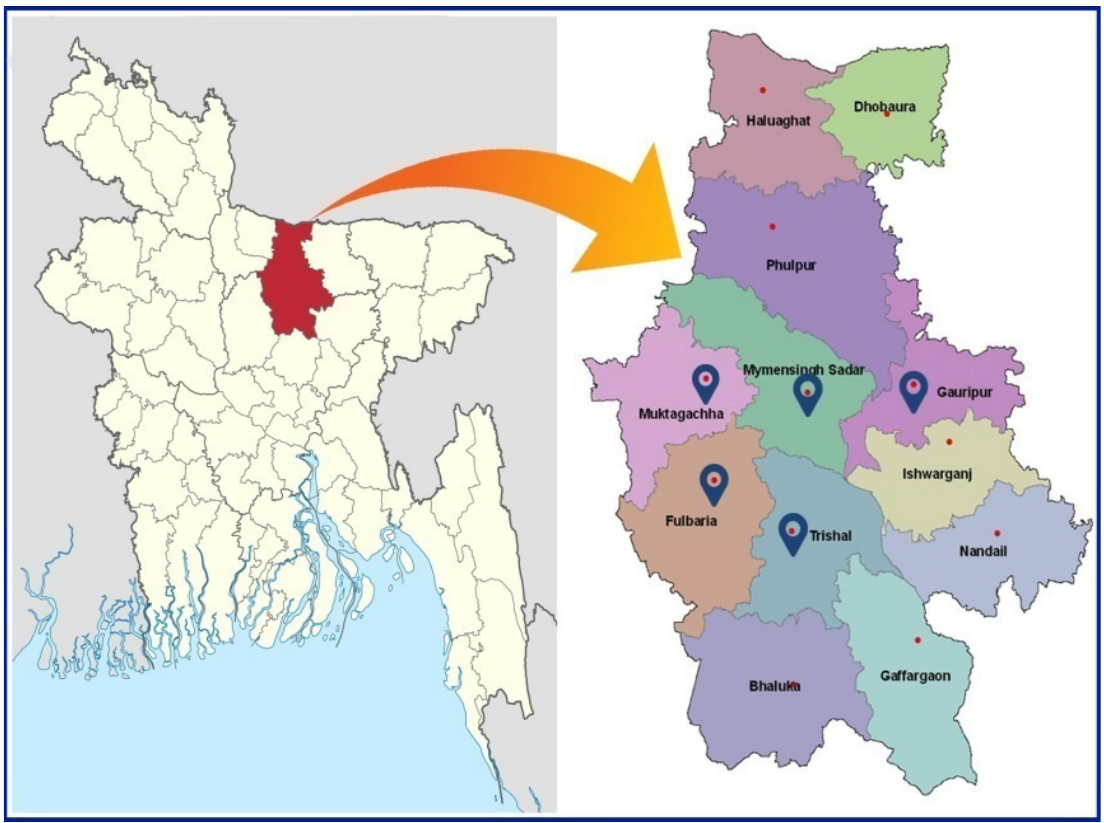
Figure 1. Study sites of the Mymensingh district.